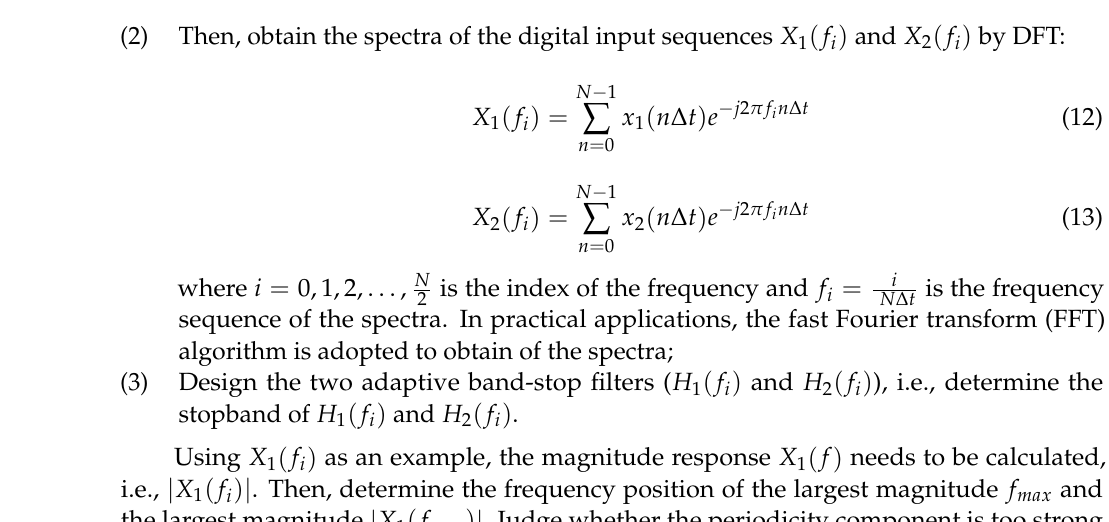
Figure 4. Magnitude responses of H 1 ( f ) and H 2 ( f ) : ( a ) H 1 ( f ) ; ( b ) H 2 ( f )